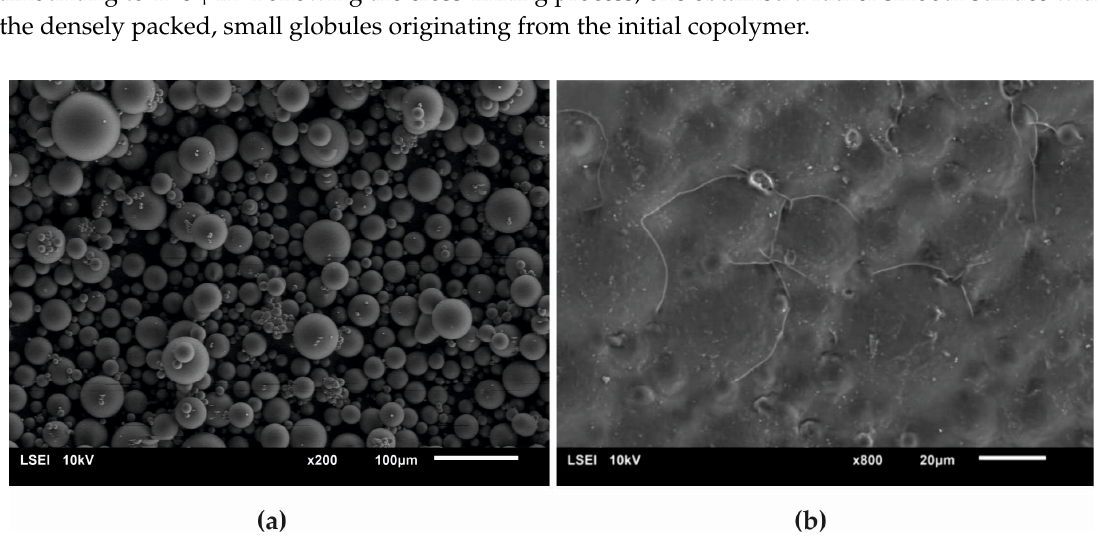
Figure 8. Surface SEM micrographs of ( a ) the initial PAc copolymer and of ( b ) the ready composite cross-linked without any addition of the HAp filler.